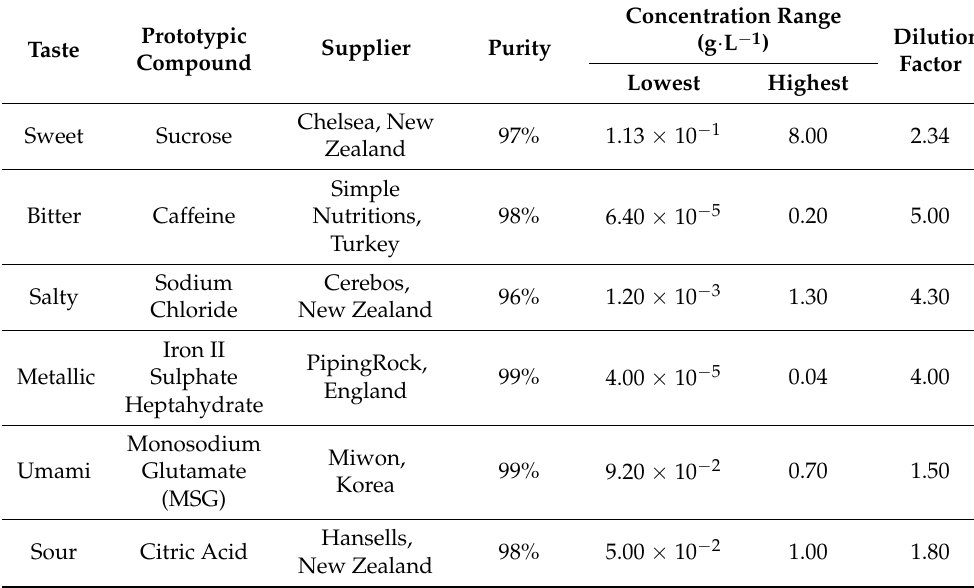
Table 1. Information of the taste compounds and their concentration range used in the present study. The specific concentration steps between the lowest and highest concentrations can be calculated by multiplying the lowest concentration by the dilution